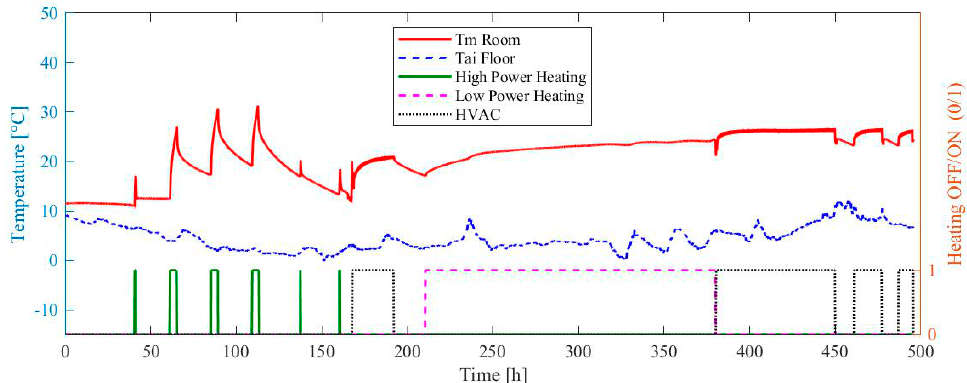
Figure 3. Development of external and conditioned room (CR) temperature (left axis) and activation of heating modes (right axis) during three week calibration